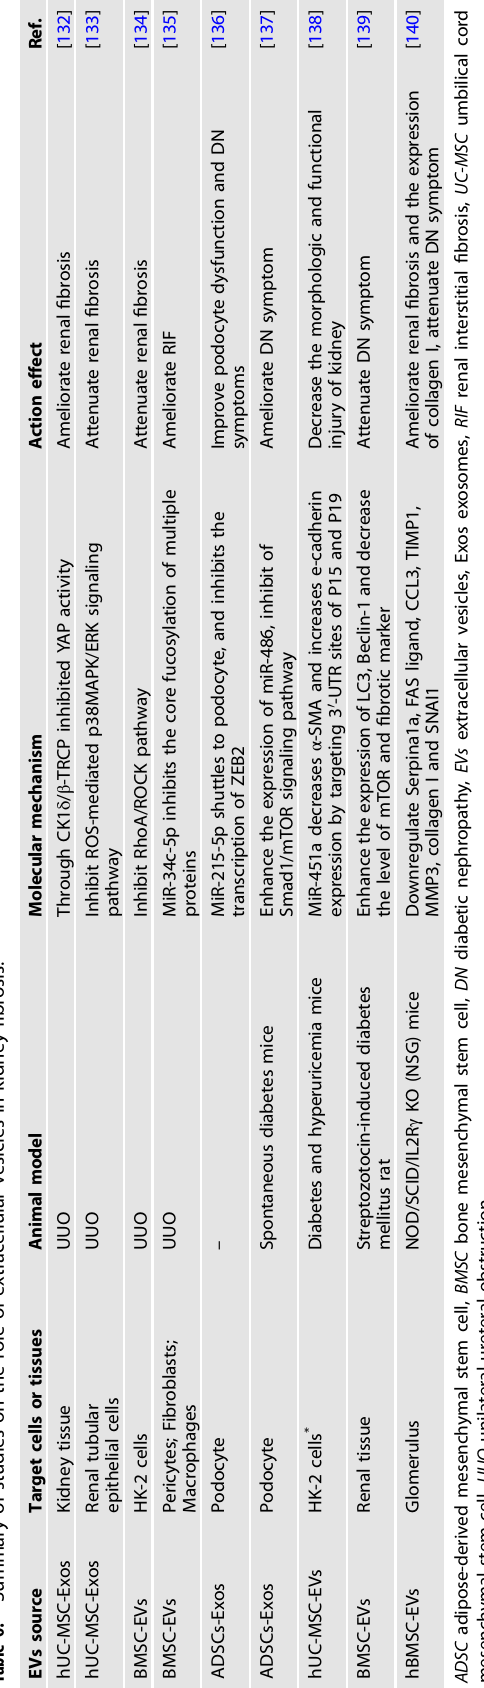
been used in clinical trials for refractory graft-versus-host disease (GVHD) [171]. The therapeutic potential of MSC-EVs has been shown in preclinical studies of both acute GVHD (aGVHD) [172 – 174] and chronic GVHD (cGVHD) [175] models. The preliminary bene fi ts of hPMSC-EVs have been reported in a patient with cutaneous cGVHD. The stiffening and dryness of skin were improved signi fi cantly after intravenous injection of hPMSC- EVs [176]. Based on the preliminary ef fi cacy and safety pro fi les, a phase 1 study has been launched to evaluate the safety and ef fi cacy of BM-MSC-derived EVs in patients with acute or chronic rejection following abdominal solid organ transplantation (NCT05215288, Table 1). It is plausible that hPSC-MSC-derived EVs will promote the clinical translation of MSC-EVs owing to the T a